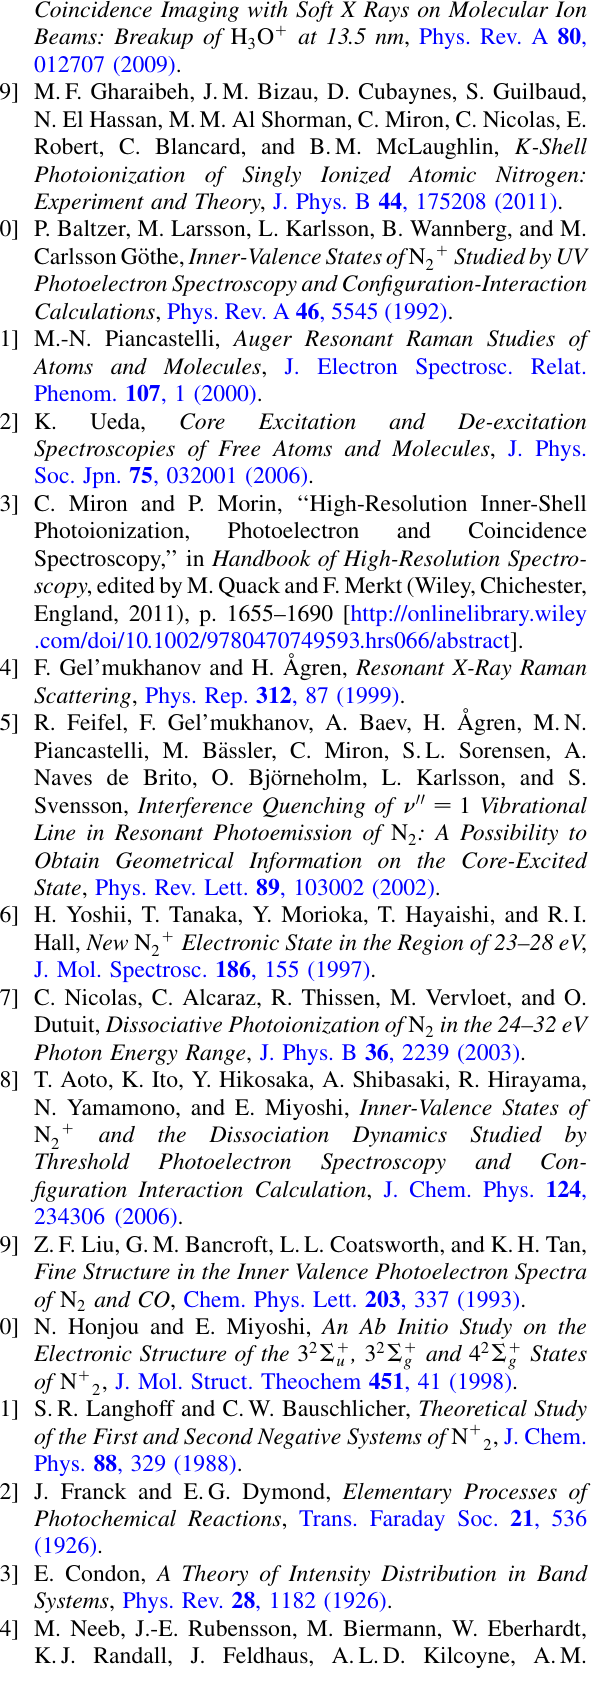
figuration Interaction Calculation , J. Chem. Phys. 124 , 234306